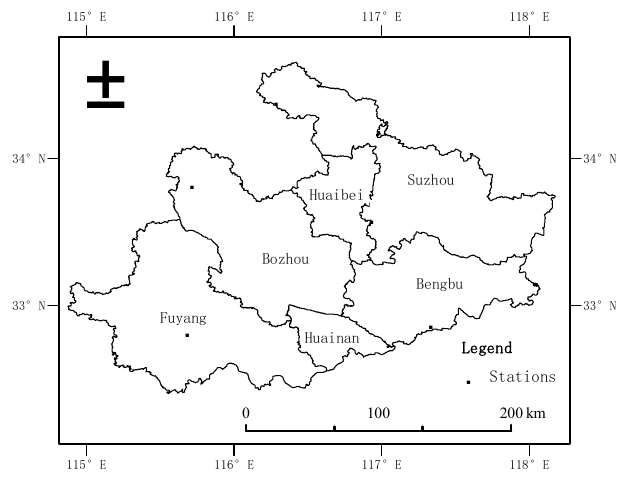
Figure 1. Administrative division map of the Huaibei Plain in the Anhui Province of China.